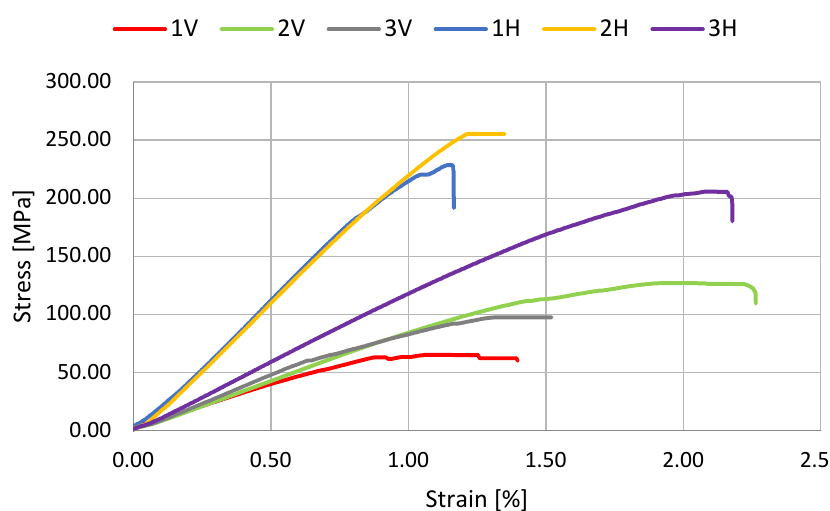
Figure 3. Representative curves for samples with 75 mm long carbon fibers.